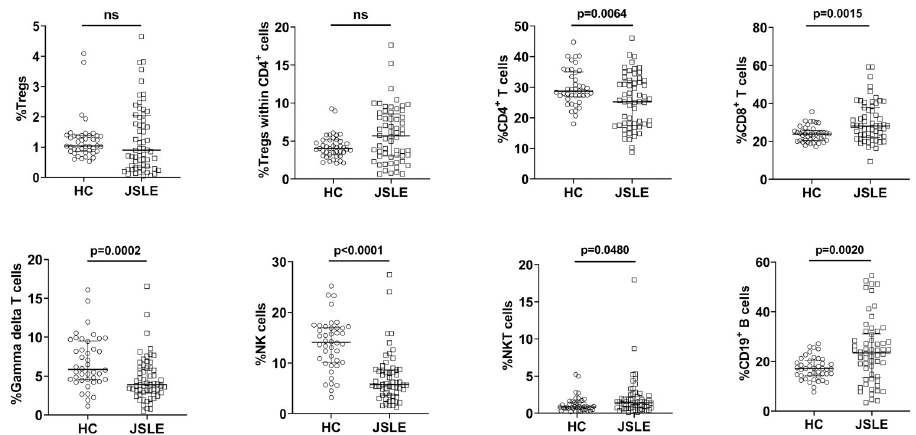
Fig 1. Differences among lymphocyte subsets between JSLE patients and HC. The data included 60 JSLE patients at enrollment and 42 age-matched HC. Horizontal solid lines represent medians and interquartile ranges. JSLE, juvenile- onset systemic lupus erythematosus; HC, healthy controls; Tregs, regulatory T cells; NK cells, natural killer cells; NKT cells, natural killer T cells; ns, not significant.